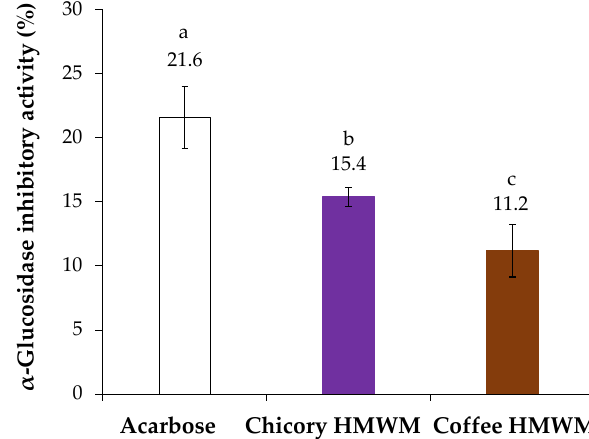
Figure 4. Inhibitory activity (%) against α -glucosidase of acarbose and chicory and coffee high molecular weight material (HMWM), at 4 mg/mL. Lowercase letters refer to significantly different values ( p < 0.05) among samples.